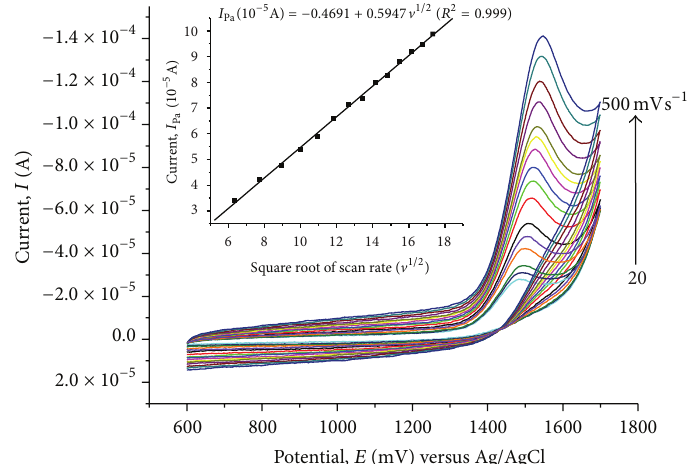
Figure 6: Cyclic voltammograms of AQMCPE in HClO4 (pH 0.56) containing 1mM of caffeine, at scan rate of 20, 30, 40, 50, 60, 80, 100, 120, 140, 160, 180, 200, 220, 240, 260, 280, 300, 350, 400, 450, and 500 mV/s (inset Plot of 𝐼 𝑝 ( A ) versus 𝑣 1/2 mV/s).